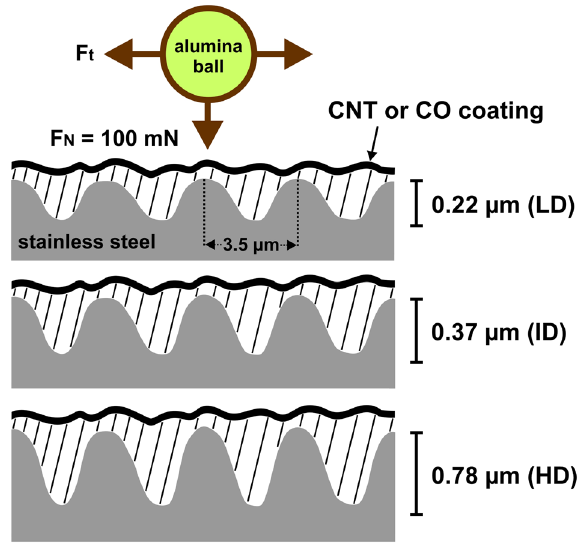
Fig. 1 Cross-section scheme of line-patterned steel substrates with varying structural depths. It illustrates the friction testing conducted on these surfaces coated with either CNTs or COs as conducted by MacLucas et al. 9